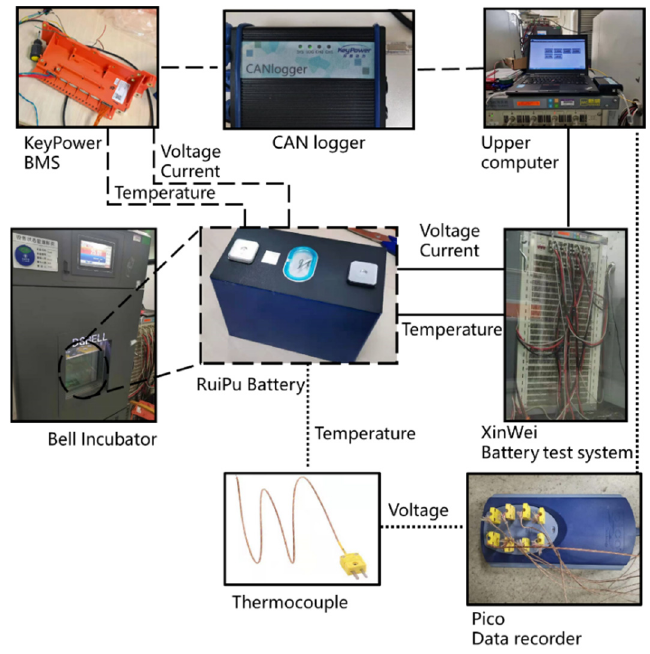
Figure 1. Experimental device.